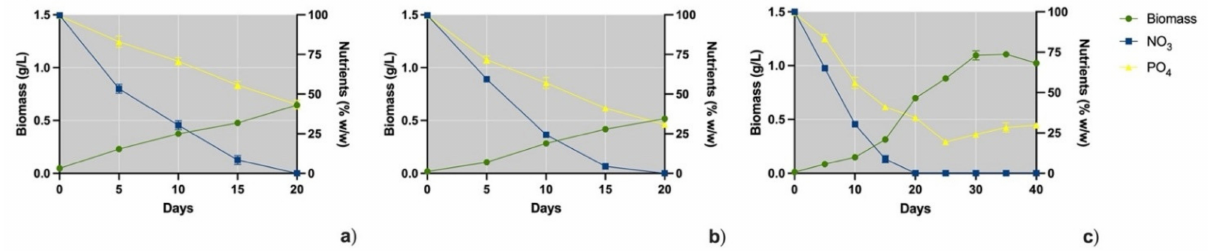
Figure 5. Biomass production and consumption of NO 3 and PO 4 in the optimized C/N/P ratio for production of carbohydrates ( a ), proteins ( b ) and lipids ( c ).